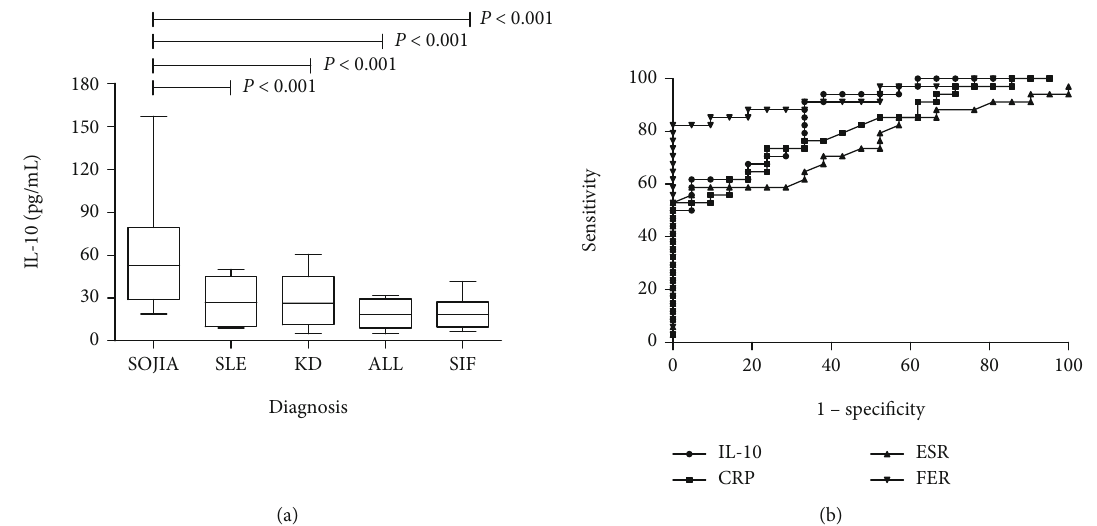
Figure 1: The expression of serum IL-10 and ROC curves. (a) Comparison of serum IL-10 levels in all patients. (b)ROC curve of IL-10, CRP, ESR, and FER in distinguishing SoJIA from other disease Table 1: Characteristics of the patients with active SoJIA or inactive disease.